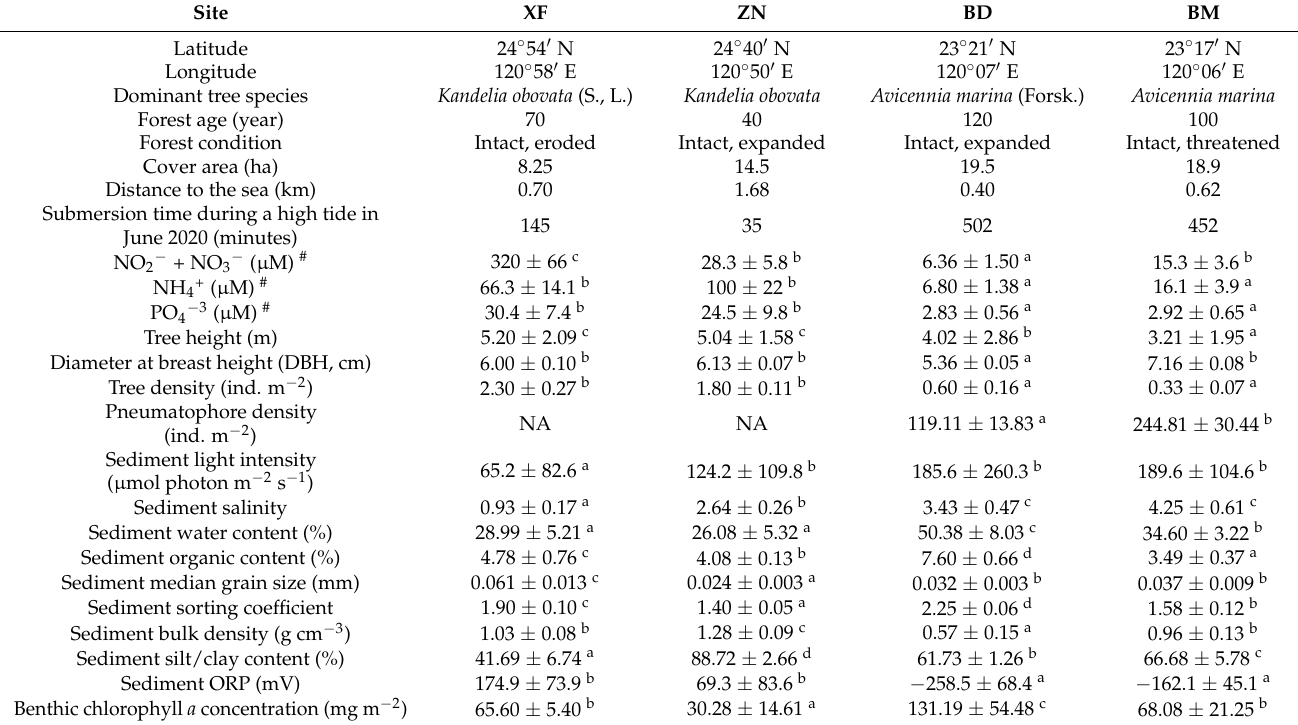
Table 1. Forest structure and sediment features (mean ± SD) of the four mangrove sites on the western coast of Taiwan. The different superscripted letters indicate significant differences ( p < 0.05), as determined by one-way ANOVA or the Kruskal–Wallis test. NA: data not